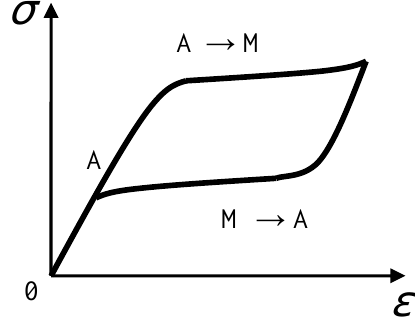
Figure 1 . Schematic sketch of the pseudoelasticity hysteresis